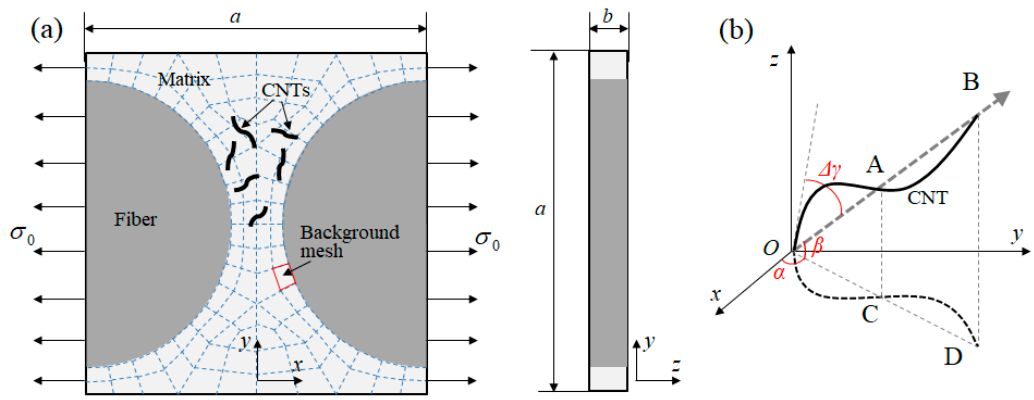
Figure 1. Schematic illustration of the optimization problem: ( a ) the fiber-reinforced composite (FRC) model (front and side view) with carbon nanotubes (CNTs) dispersed in the matrix and ( b ) the wavy shape of CNTs.